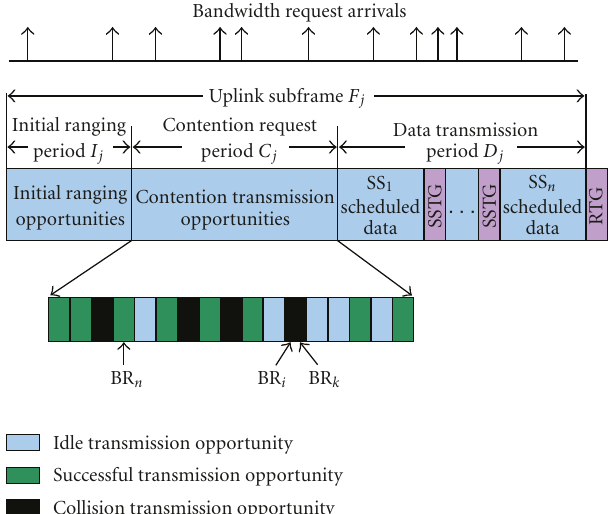
Figure 5: Analysis system